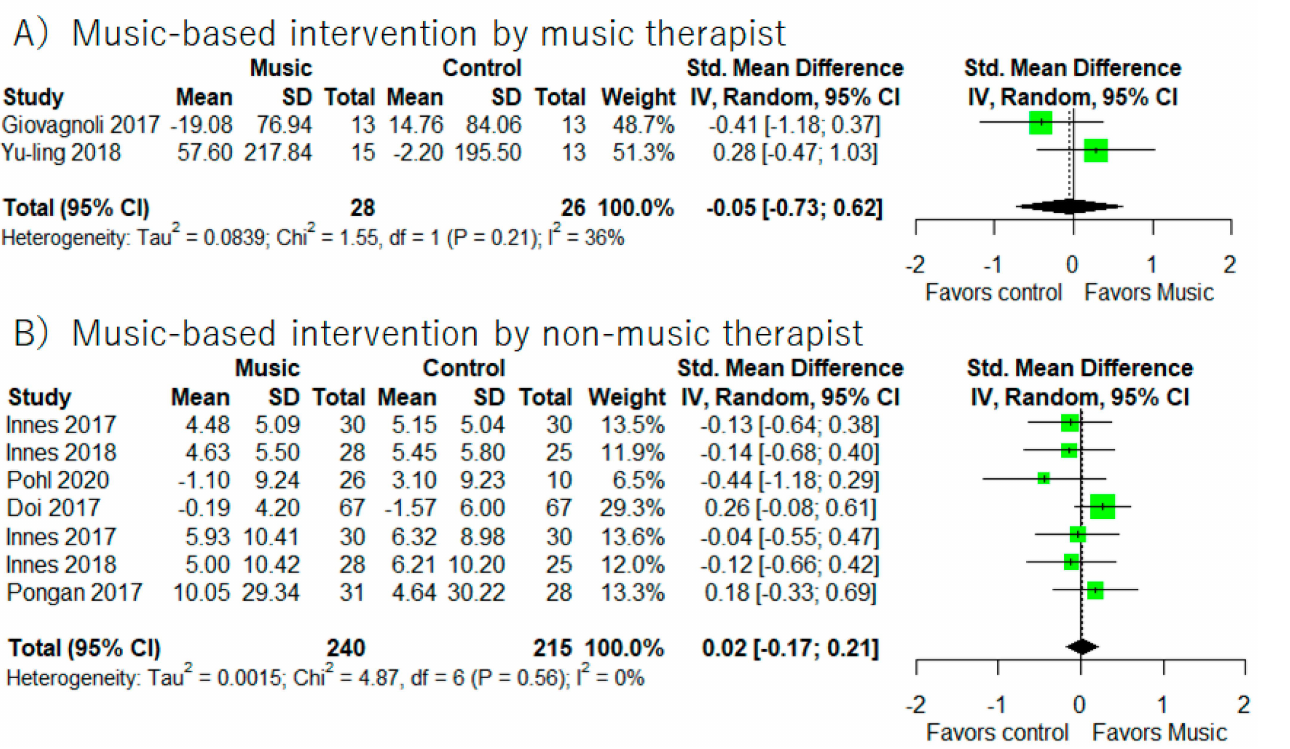
Figure 6. Trial level data, effect estimates, and forest plot in supplementary meta-analyses for music- based intervention by music therapist ( A ), music-based intervention by non-music therapist ( B ). The area of green square is proportional to the study’s weight in the